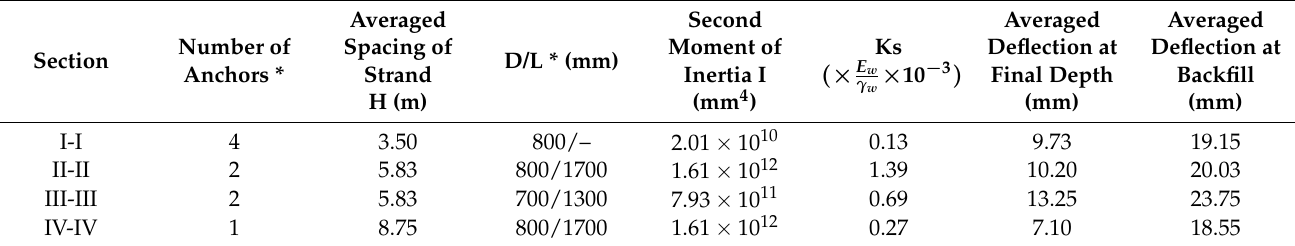
Table 5. Relationship of stiffness and horizontal deflection at the top of the retaining wall.